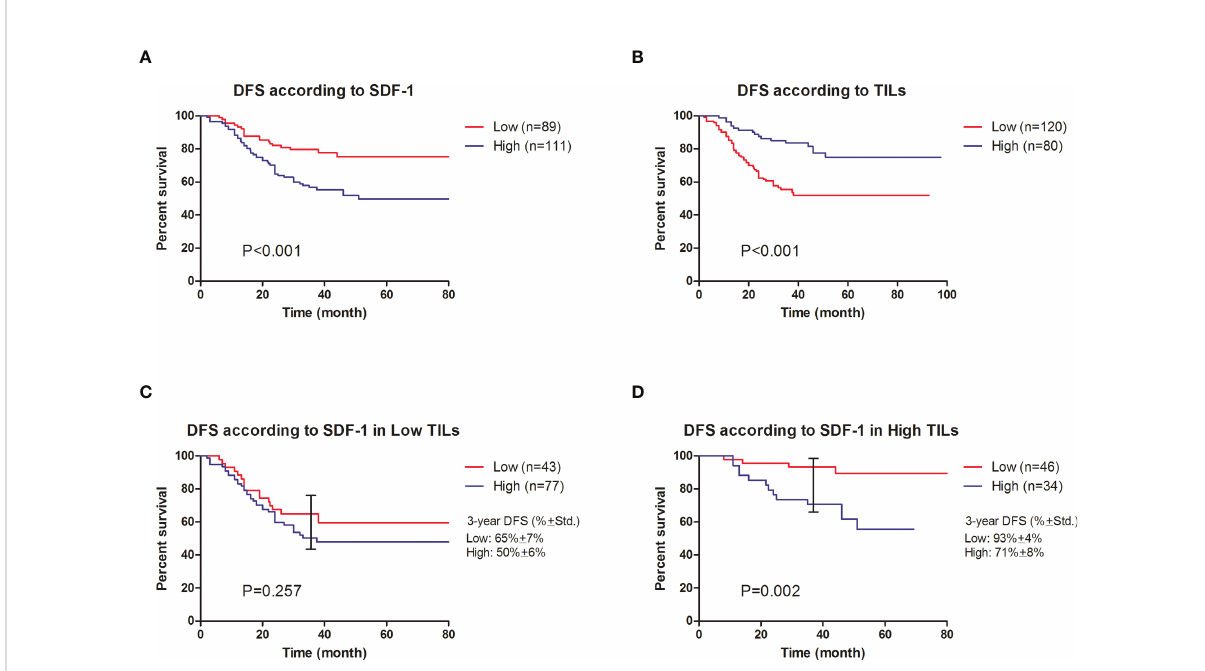
FIGURE 3 Cumulative disease-free survival of nonpCR patients after NAC. (A) DFS according to SDF-1 expression (log-rank test P<0.001). (B) DFS according to TIL expression (log-rank test P<0.001). (C) DFS according to SDF-1 expression in low TIL patients (log-rank test P=0.257. The observed 3-year DFS rates were 65% ± 7% and 50% ± 6% in the low SDF-1 and high SDF-1 groups, respectively. (D) DFS according to SDF-1 expression in high TIL patients (log-rank test P=0.002). The observed 3-year DFS rates were 93% ± 4% and 71% ± 8% in the low SDF-1 and high SDF-1 groups,